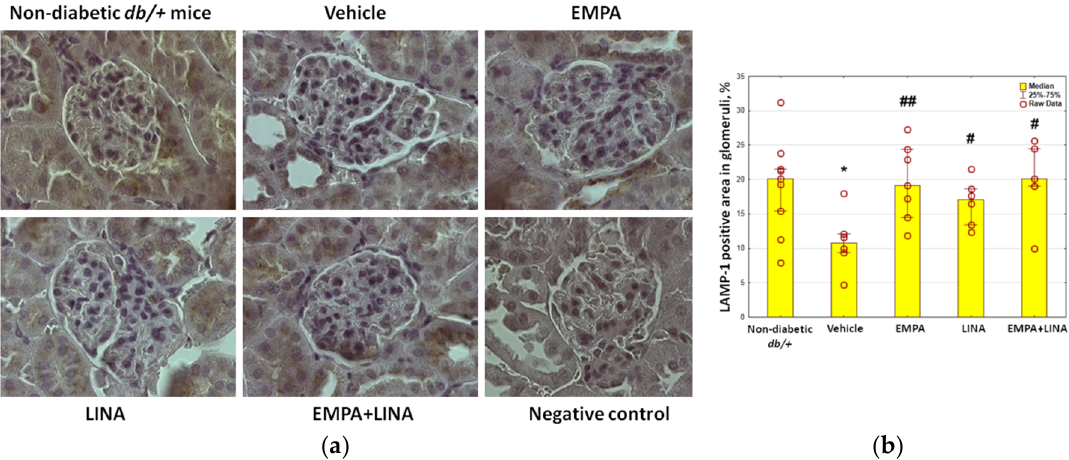
Figure 6. Glomerular LAMP-1 expression in non-diabetic db /+ mice and diabetic db / db mice. ( a ) IHC-pictures of glomeruli of non-diabetic db /+ mice and db / db mice treated by vehicle, empagliflozin, linagliptin, or empagliflozin–linagliptin; magnification × 400; (b) Quantitative analysis of LAMP-1-positive areas in glomeruli. Data are presented as a bar graph (median, lower and upper quartile) with individual data set (dots); * p < 0.05 vs. non-diabetic db /+ mice; # p < 0.05, ## p < 0.01 vs. vehicle-treated db / db mice (Mann–Whitney U -test).